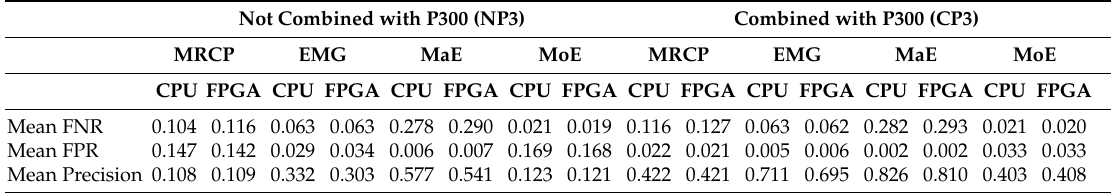
Table 2. Mean False Negative Rate (FNR), False Positive Rate (FPR = 1-Recall) and Precision for the Hybrid Movement Prediction. Not Combined with P300 (NP3) Combined with P300